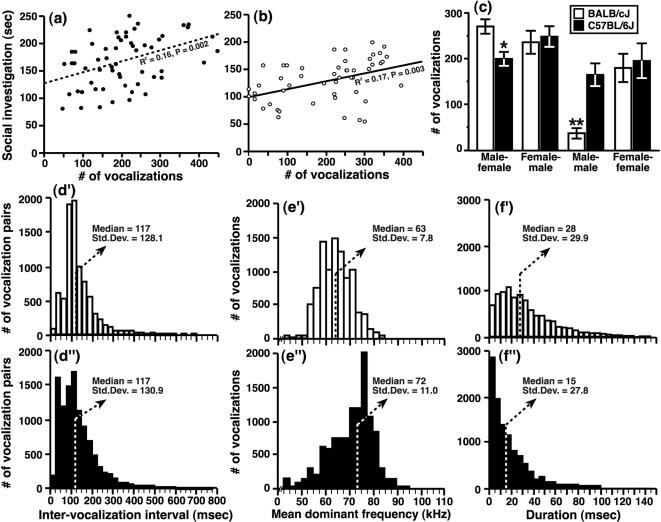

Production and sonographic characteristics of ultrasonic vocalizations during the social interactions of early-adolescent mice. USV emission was positively associated with the SI responses of early-adolescent (a) B6 and (b) BALB mice. (c) USV production was selectively modulated during social interactions that involved a male test mouse from the BALB strain. (d–d′) Emission rates were similar for mice from both strains when USVs were detected. However, compared to BALB mice, the USVs of B6 mice occurred at (e–e′) higher average frequencies and lasted for (f–f′) shorter durations. Data in Figures d–f and d′–f′ are presented as frequency distributions of the raw acoustic signal that was collected during SI tests on PD 30/31. A portion of the data (<0.5% of the sample from each strain) is not illustrated to keep the abscissa of each distribution within a reasonable size for presentation. Data in Figure 5c are presented as the mean±SEM (* P<0.05, ** P<0.01 for BALB vs. B6 mice).